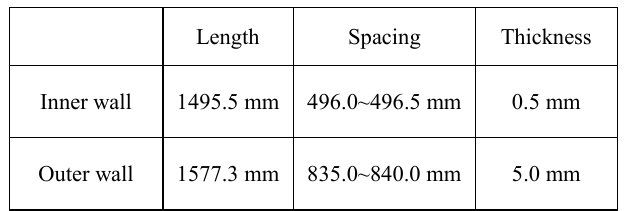
Table 1. Main parameter of the